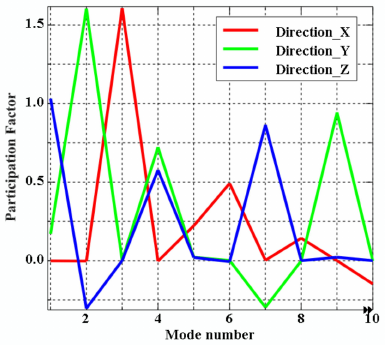
Figure 16. Translational mode modal participation factor.